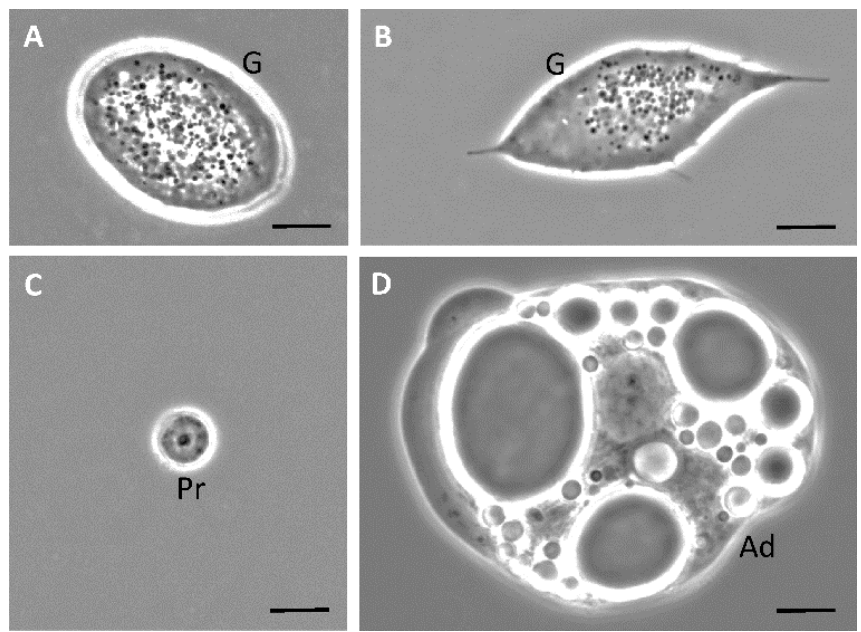
Figure 2. ( A – D ) Phase contrast microscopy of fifth instar nymphs hemocytes of Dipetalogaster maxima . G, granulocyte; Pr, prohemocyte; Ad, adipohemocyte. Bars: 10 μ m.